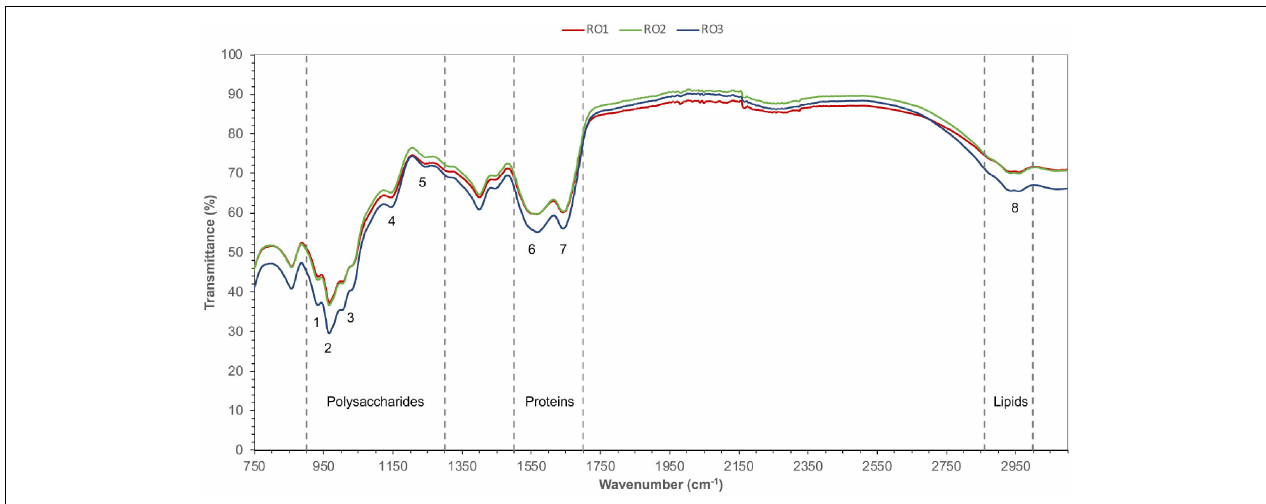
FIGURE 3 | FTIR spectra of EPS. Different functional groups (1–8) belonging to the expected type of chemical compounds (polysaccharides, proteins, and lipids) were identified based on characteristic IR bands. Transmittance (%) is given along the y-axis, while the wavelength of infrared radiation is indicated along the x-axis. Peak 1 and 2 ( α -1,4 glycosidic linkage), peak 3 (uronic acids), peak 4 ( O -acetyl group), peak 5 (carboxylic group), peak 6 (amide II), peak 7 (amide I), peak 8